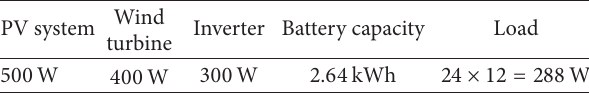
Table 3: The optimized hybrid system